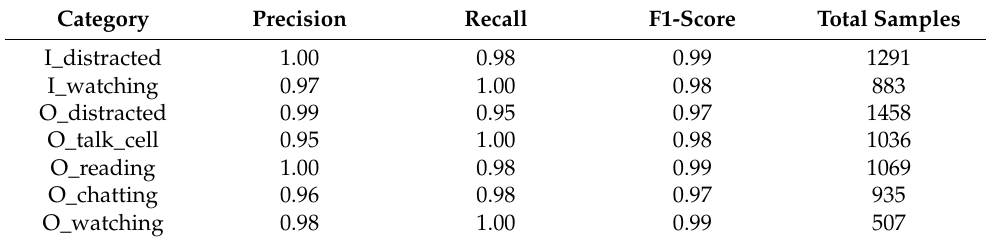
Table 7. Evaluation metrics of the ResNet-50 model.